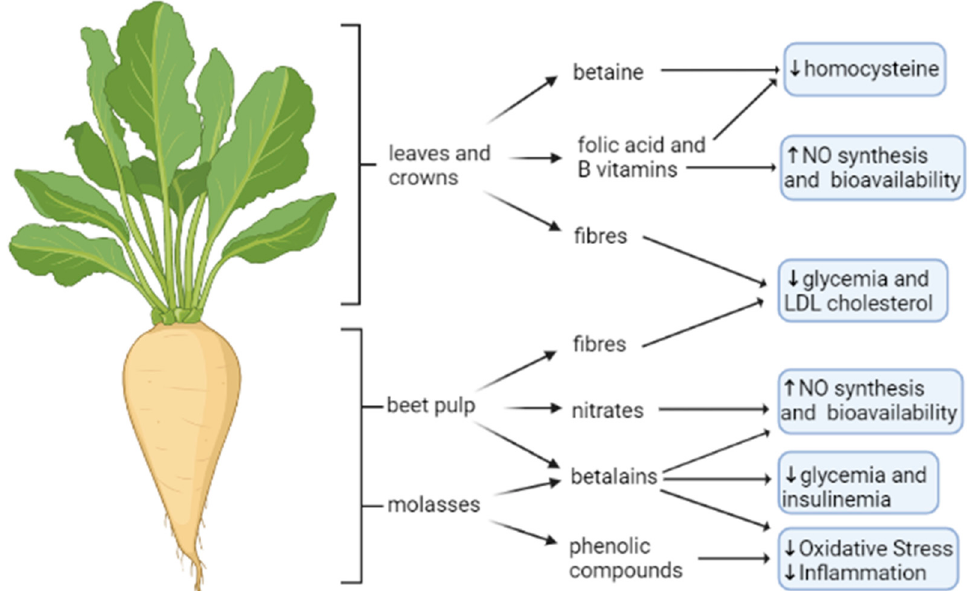
Figure 4. Sugar beet bioactive compounds and their cardio- and vasculoprotective actions. The entire sugar beet plant is a source of bioactive molecules with a potential cardio- and vasculoprotective role. Betaine and B vitamins from leaves and crown are involved respectively in homocysteine detoxification and NO synthesis. Nitrates, betalains and phenolic compounds from beet pulp, and its by-product molasses, are involved in NO bioavailability, glycemia control and reduction in oxidative stress and inflammation. Moreover, fibers from different plant parts exert hypoglycemic and cholesterol-lowering effects. The figure is original and created with BioRender.com.